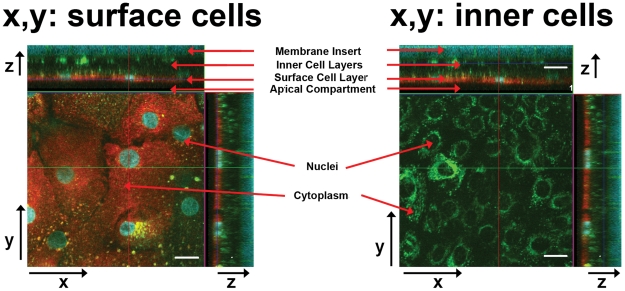
Fluorescent confocal images of NHBE cell multilayers on the porous membrane with Z-stacks.Cell multilayers were stained with MTR, Hoe and LTG. Each compartment (membrane inserts (bottom), inner cell layers, surface cell layer, and apical compartment (top)) through z-axis were indicated with the red arrows in x–z planes while cell nuclei and cytoplasm in x–y planes. The panel to the left shows an x, y cross section through the apical surface layer of the cell multilayer. The panel to the right shows an x, y cross section through the inner cell layer of the cell multilayer. Scale bar: 20 µm.